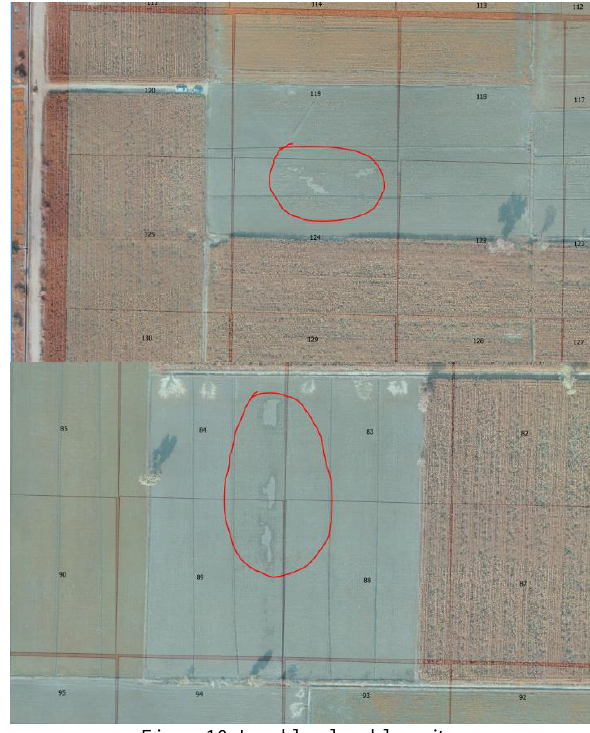
Figure 10. Land level problem sites